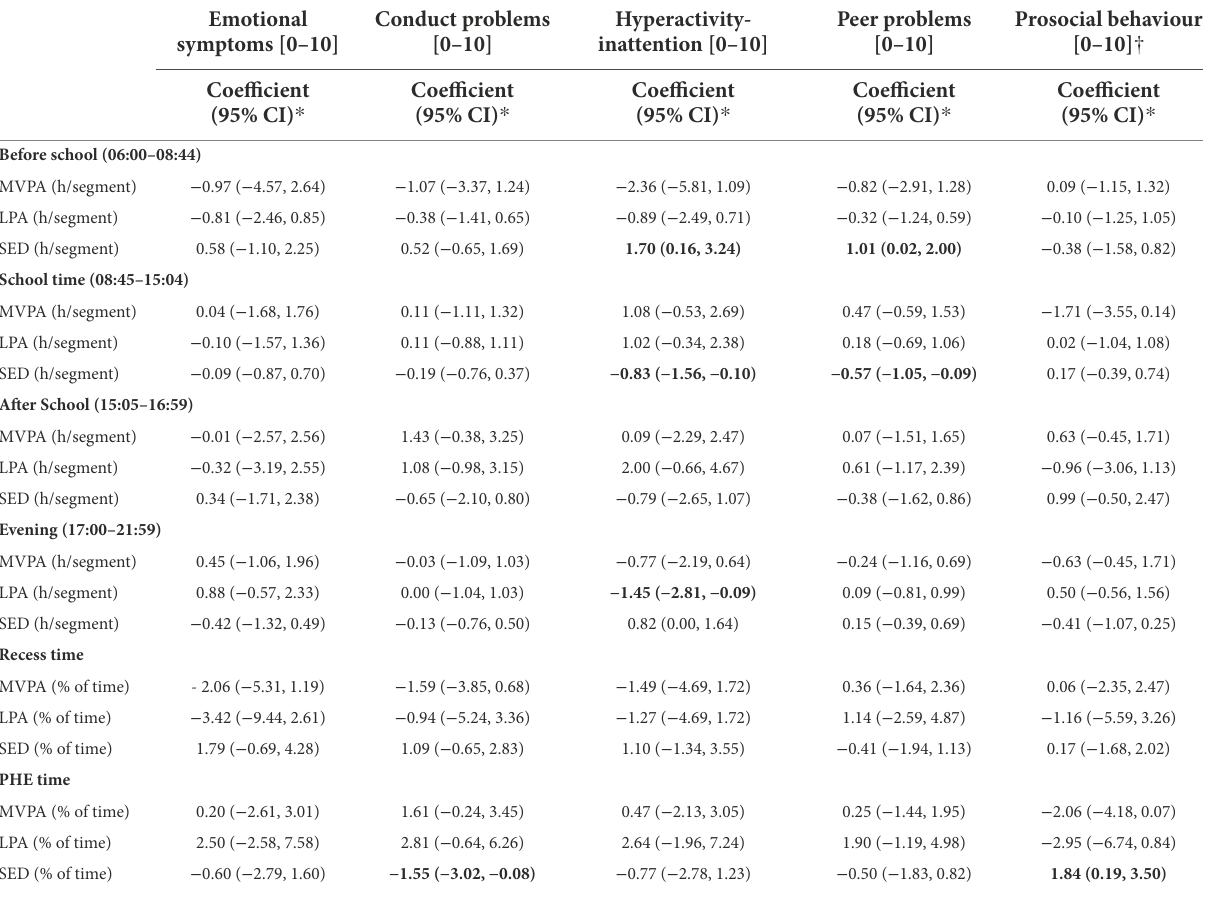
TABLE 4 Association of time-segmented SED, LPA, and MVPA with mental health indicators ( n =